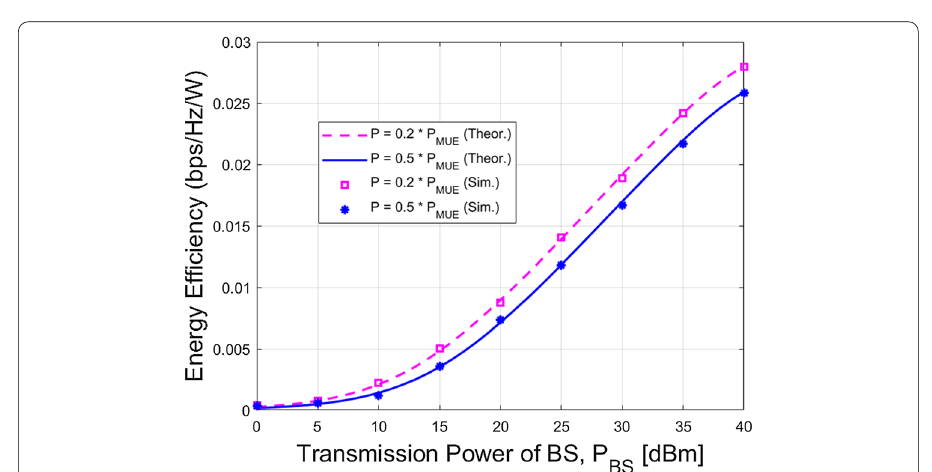
Fig. 7 Energy efficiency vs. transmission power of BS in